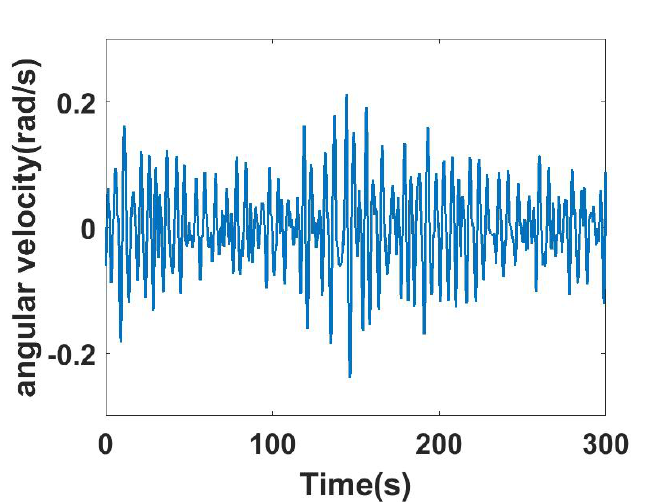
Figure 16. The angular velocity.